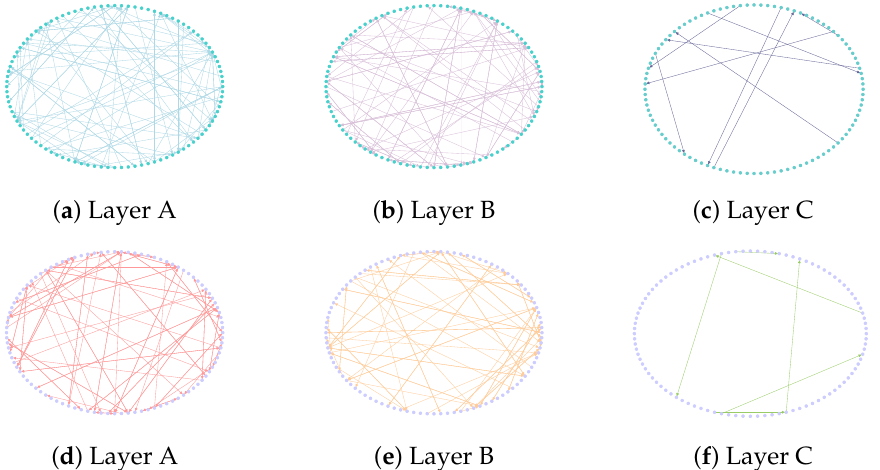
Figure 6. Multi-layer networks structure illustration. ( a – c ): Fault Miss − 20 − 0 in SEU, ( d – f ): F5 in